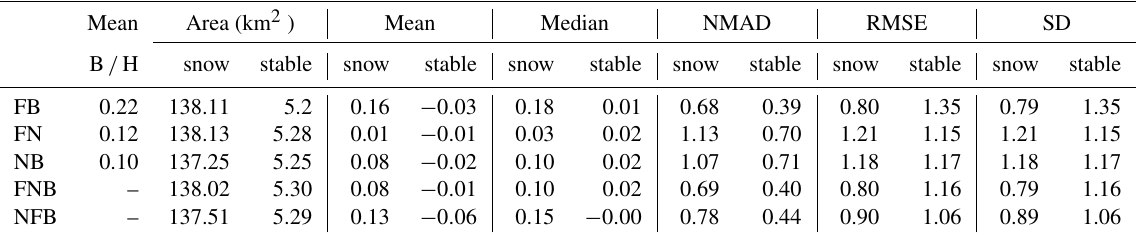
Table 2. Comparison of the snow depth residual (HS Pléiades minus HS ASO) and stable-terrain elevation difference (Pléiades) for different image acquisition geometries for SGM-binary options only. HS Pléiades are calculated from a combination of images taken looking to the front (F), the nadir (N) or the back (B). All metrics are in meters except the mean B / H for bi-stereo geometries, which is dimensionless. The bold line is common to this table and Table 3.